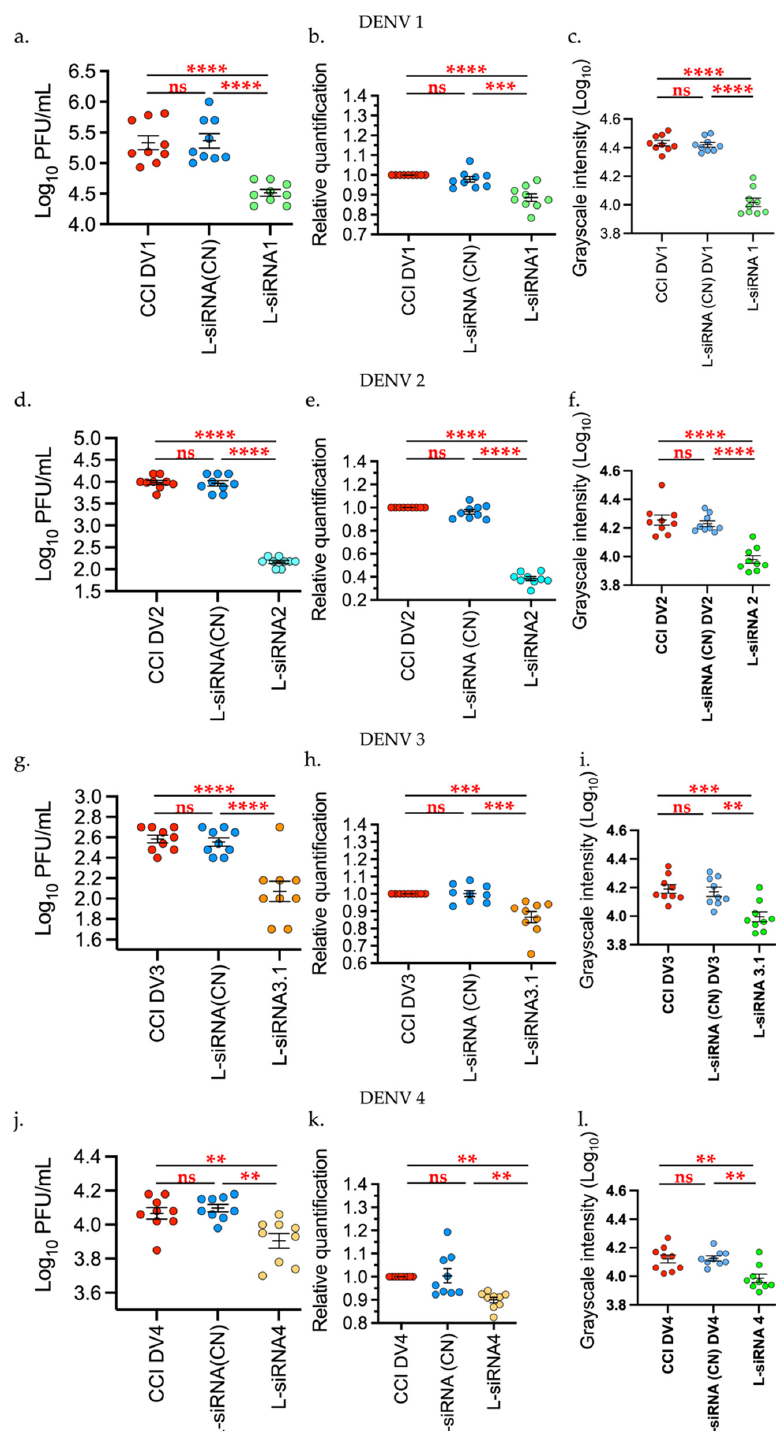
Figure 4. Liposomes-siRNAs inhibit the DENV 1–4 replication. The evaluation was performed through: ( a , d , g , j ) Plaque assay, ( b , e , h , k ) relative expression of viral RNA through RT-qPCR, and ( c , f , i , l ) production of the NS1 protein via dot blot; the last was measured through intensity in grayscale in an equivalent area in all the samples (911 square pixels), analysis was performed with Fiji and was represented as Log 10 . Infection control (CCI DV), Negative control (L-siRNA (CN)). Data are expressed as Mean + SEM of the three independent assays in triplicate. Tukey’s multiple comparisons test. ** p < 0.001 *** p < 0.0001 **** p < 0.00001. Graphics and analysis constructed through GraphPad Prism